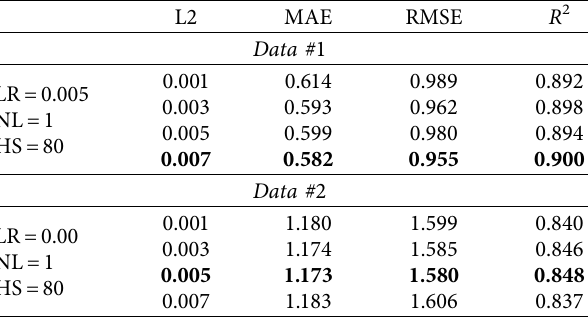
Figure 6: Adjusting model hyperparameters with Bayesian optimization. (a) Bayesian optimization adjusts the initial learning rate. (b) Bayesian optimization adjusts the initial learning rate and hidden unit size. Table 3: Infuence of diferent L2 regularization coefcients on the model.